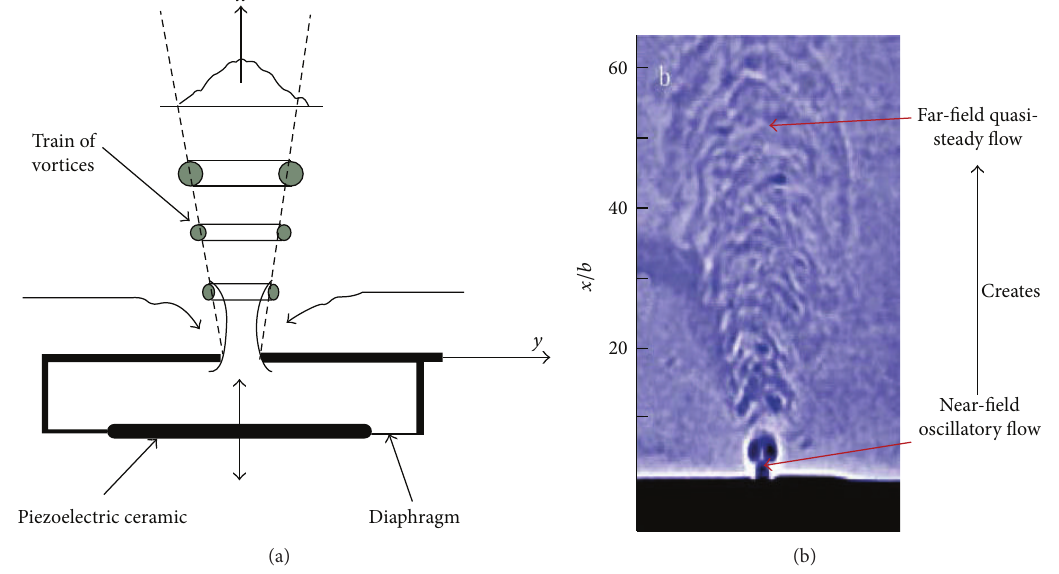
Figure 7: (a) Schematic of a synthetic jet actuator and (b) Schlieren image of a rectangular synthetic jet